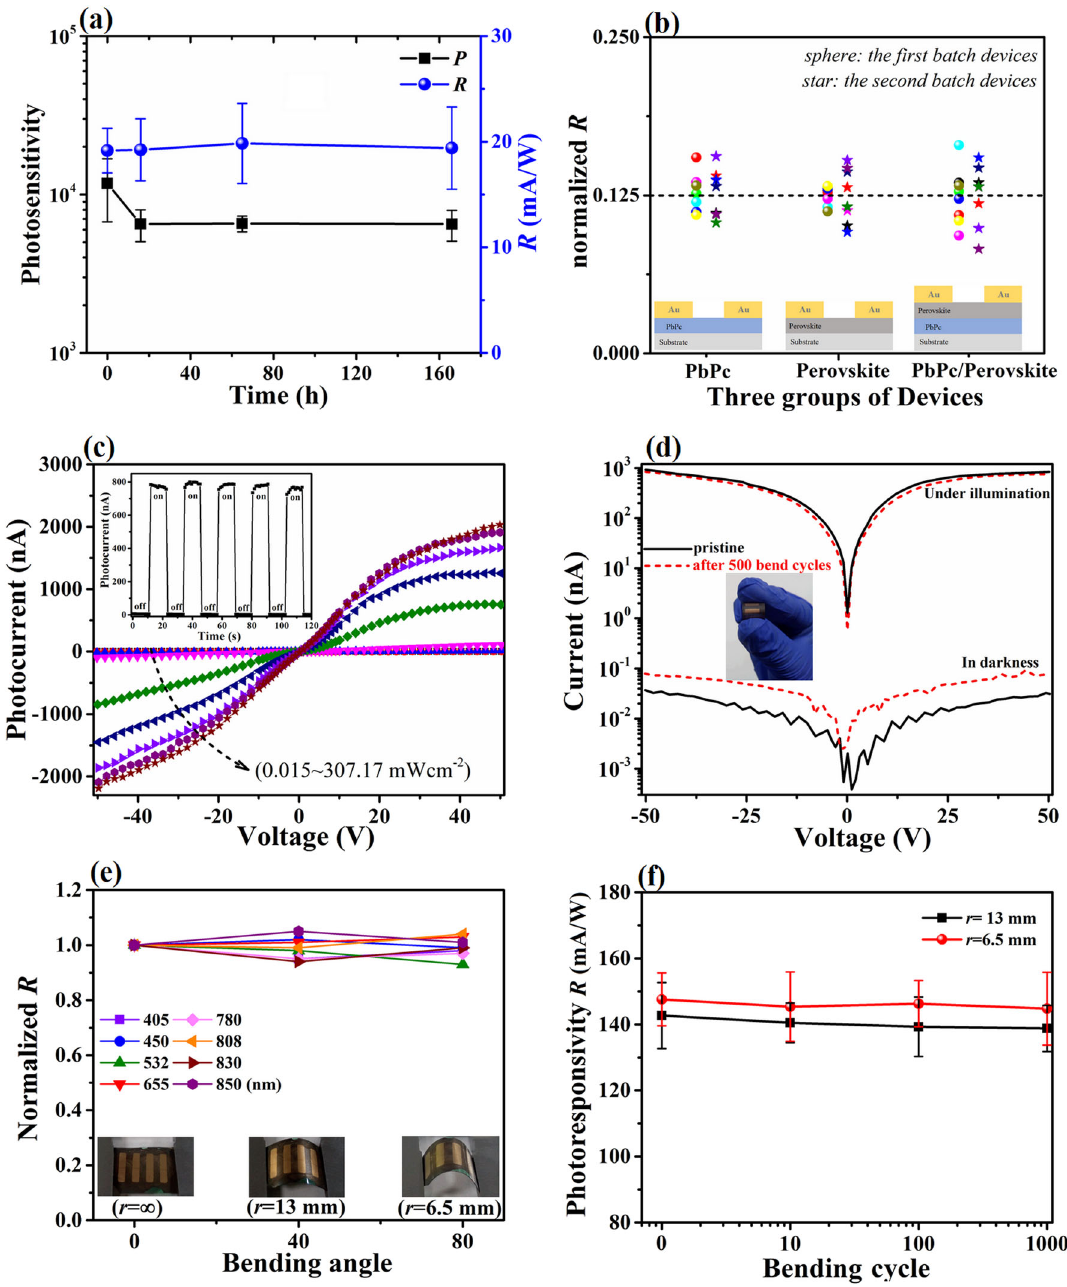
Fig. 5 Device stability, reproducibility, uniformity and fl exibility measurements of the perovskite-PbPc series photodetectors. a The photosensitivity and photoresponsivity versus time of exposure in ambient condition for PbPc/Perovskite heterostructured devices. b The distribution of normalized photoresponsivity R for single PbPc, single perovskite and PbPc/Perovskite heterostructured devices in two batches of samples (a batch of samples have 8 devices). c I – V curves of the fl exible device with PbPc/MAPbI 3 − x Cl x heterostructure fabricated on transparent PET substrate for 655 nm illumination; the inset is time-dependent photocurrent measurement at P inc = 31.66 mW cm − 2 . d I – V curves of the fl exible photodetector under dark and illumination without bending and after 500 bend cycles; the inset is the photograph of the fl exible photodetector. e Plot of photoresponsivity R versus bending angle (corresponding to curvature radius r ) of the fl exible photodetector under broadband light excitation. The insets show corresponding photographs of the device under the different bending states. f Photoresponsivity variations with increasing number of bending cycles at different curvature radius under 655 nm light